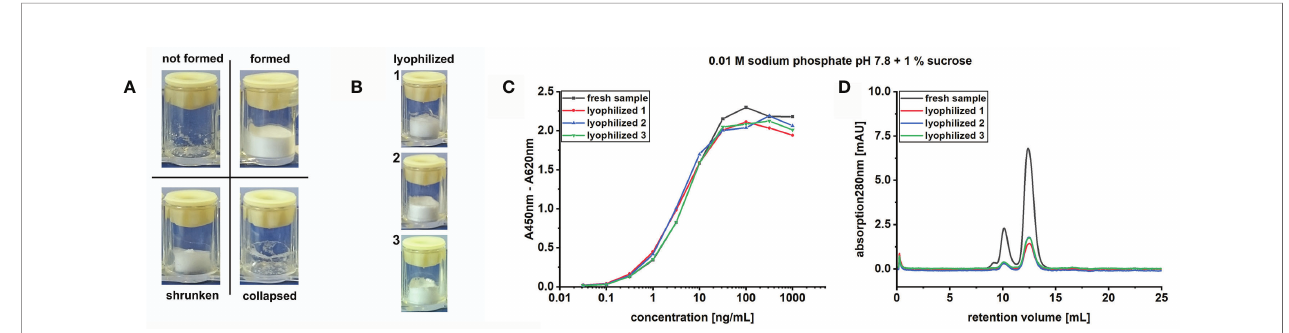
FIGURE 1 | Lyophilization protocol screening parameters. (A) Cake appearance categorization based on optical evaluation. Formed or formed and shrunken cakes are assigned a “ + ” in Table 1 or an “ x ” when dif fi cult to reconstitute, not-formed or collapsed cakes receive a “ - ” in the same table. (B) Exempli fi cation of correctly formed cakes in independent sample triplicates. Comparison of fresh versus lyophilized sample in (C) indirect ELISA, to study the molecules binding activity, or (D) in SEC, for the determination of the molecular mass distribution. SEC was performed using 50 µg fresh or 10 µg lyophilized